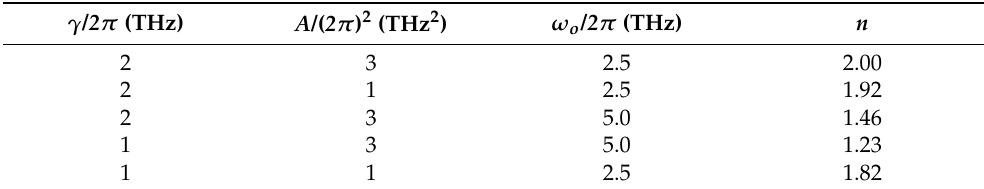
Table 1. The power exponent of AC conductivity at frequency range 300–600 GHz for various parameters values of Equation (8), according to Equation (9). The values of the rest parameters of Equation (9) were keeping constant as those of Figure 1.